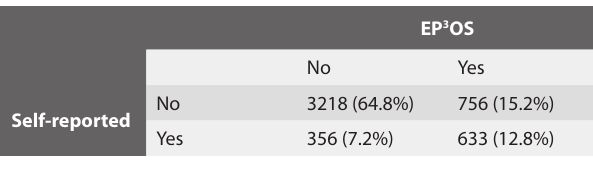
Table 1. The agreement between diagnoses of chronic rhinosinusitis based on EP3OS criteria and self-reported, physician diagnosed